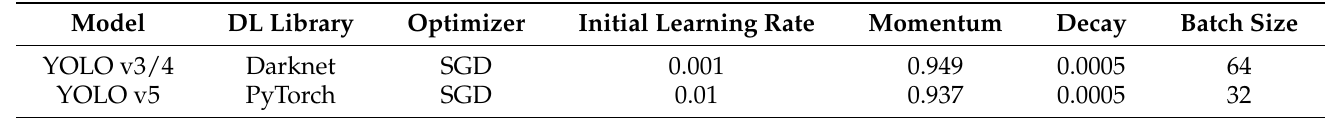
Table 2. Training